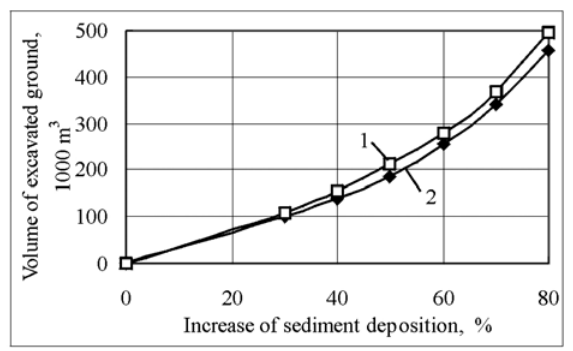
Fig. 10. Dependence of desired increase in sediment deposition on volume of ground to be excavated from the channel: 1 – channel depth 2.5 m; 2 – channel depth 3.0 m